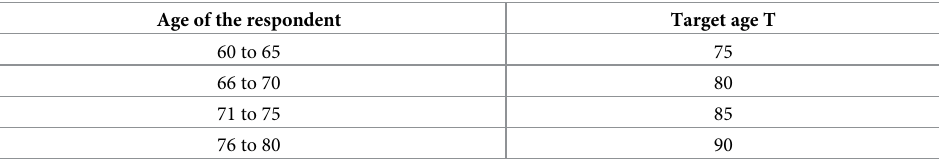
Table 1. Target ages (T) in the SHARE question about chances for survival to age